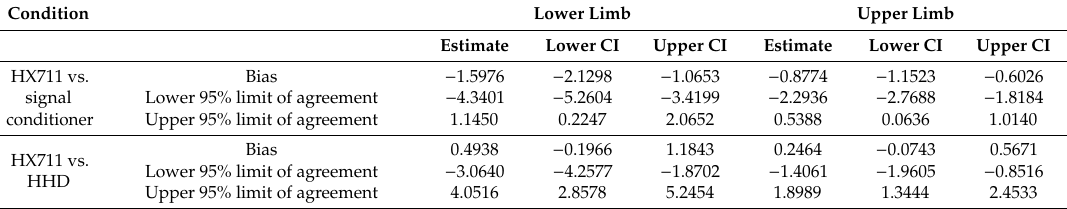
Table 2. Session one summary of the mean difference comparison results between two pairs of instruments for maximal isometric leg extension (lower limb) and maximal isometric bicep flexion (upper limb), including the mean difference, and the upper and lower 95% limits of agreement (mean ± 1.96 * SD). Condition Lower Limb Upper Limb Estimate Lower CI Upper CI Estimate Lower CI Upper CI HX711 vs. signal